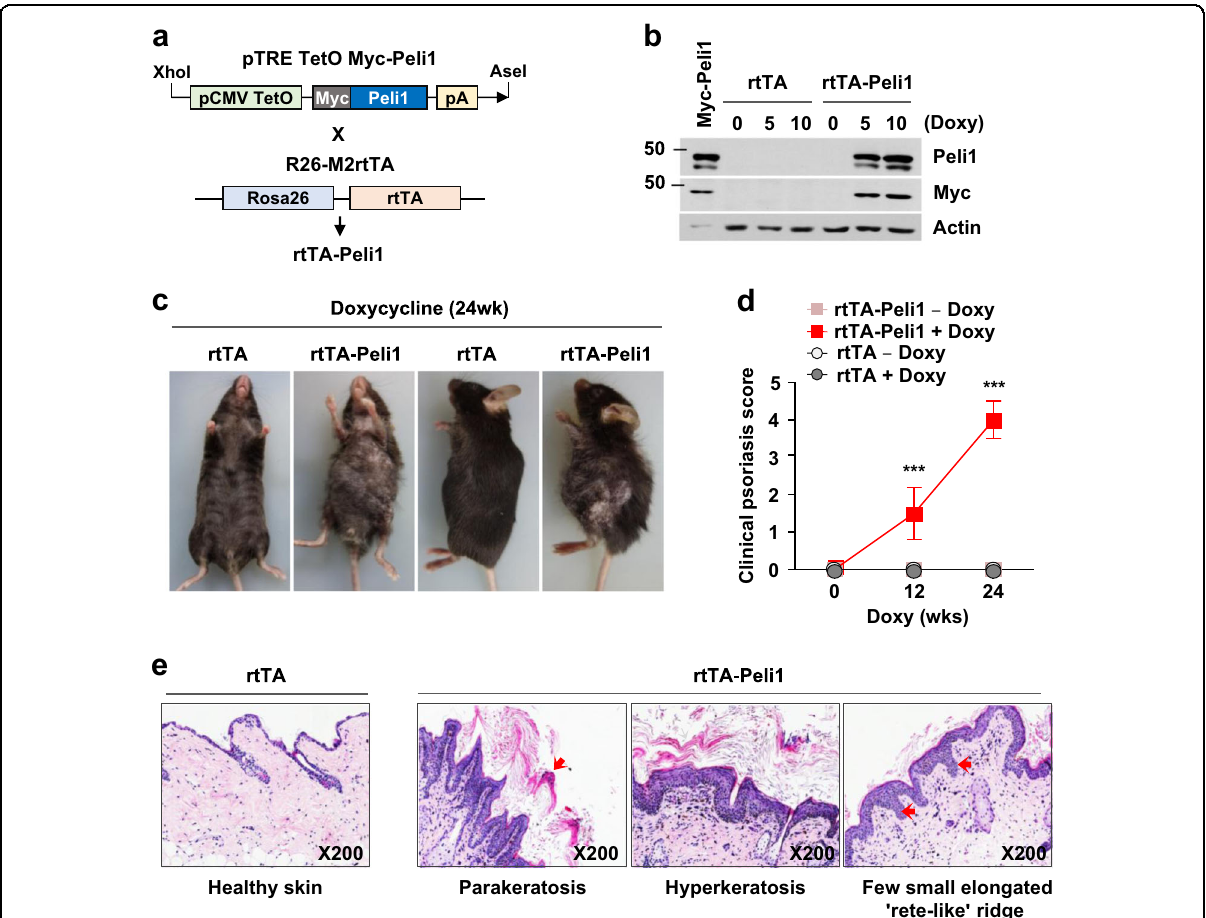
Fig. 2 Development of epidermal hyperplasia and psoriasis-like skin in fl ammation in inducible transgenic mice expressing the human Peli1 gene. a Generation of inducible human Peli1 transgenic mice. The cDNA sequence for human Peli1 was placed under the Tet-responsive promoter and introduced into fertilized mouse oocytes. To generate rtTA-Peli1 mice, the founders were crossed with R26-M2rtTA mice (B6.Cg-Gt (ROSA)26Sor tm1(rtTA*M2)Jae /J). For inducibility, Myc epitope-tagged human Peli1 gene sequences under the control of the TetO promoter and human early cytomegalovirus enhancer were included. b Immunoblotting analysis of tissues derived from rtTA and rtTA-Peli1 mice using antiPeli1 and antiMyc antibodies revealing Peli1 protein expression. Doxy doxycycline treatment. c Adult rtTA control mice and rtTA-Peli1 inducible transgenic mice were treated with or without doxycycline (2 mg/mL) for 12 weeks. Offspring of three rtTA-Peli1 founder lines exhibited macroscopic pathologies after doxycycline administration. More than 95% of rtTA-Peli1 mice showed several psoriasis-like features, including extensive erythema, hair loss, severe pruritus, and loosely adherent silver-white scaling. d Clinical psoriasis scores of rtTA and rtTA-Peli1 mice treated with or without doxycycline are shown. Scores derived from 3 to 5 mice per group. Data are presented as the means ± SEMs. *** P < 0.001, two-way ANOVA. e H&E staining and immunostaining of representative skin